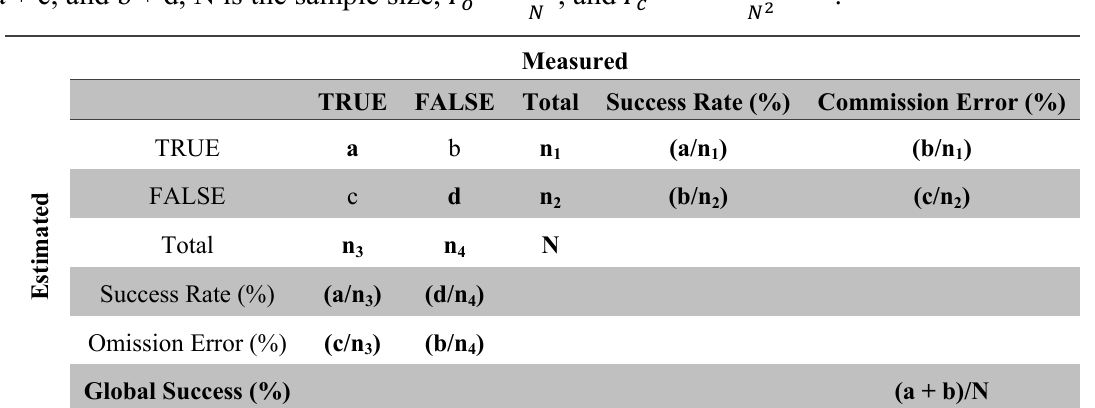
Table 3. Simplified diagram of the parameters used in the confusion matrix and to calculate the Kappa index: a and d are the number of well-classified values, b and c are the number of misclassified values, n a + c, and b + d, N is the sample size, (cid:1842)